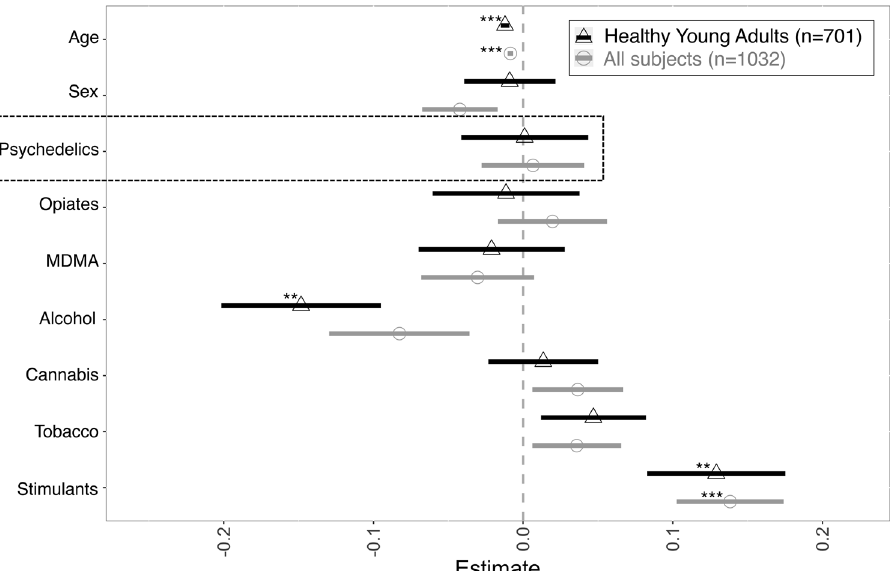
Figure 2. Drug use and schizotypy. Regression coefficient plot of models with all screened subjects included (n = 1032), and only subjects that met study criteria (n = 701). ** p < 0.01, *** p < 0.001.